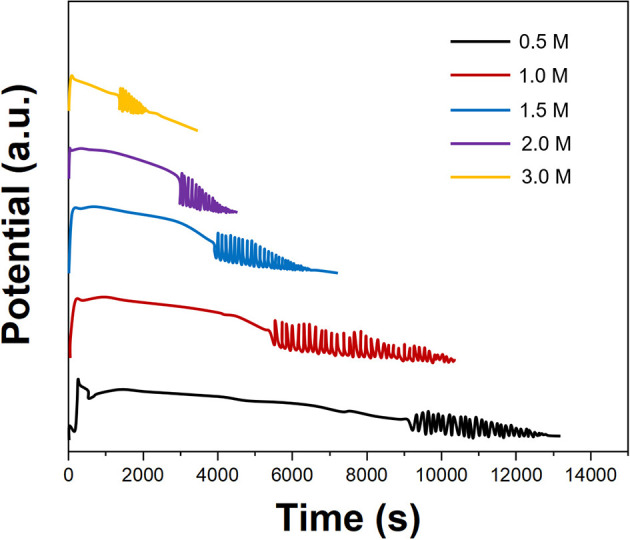
Oscillating profiles of Prunus persica recorded using different concentrations of H2SO4.